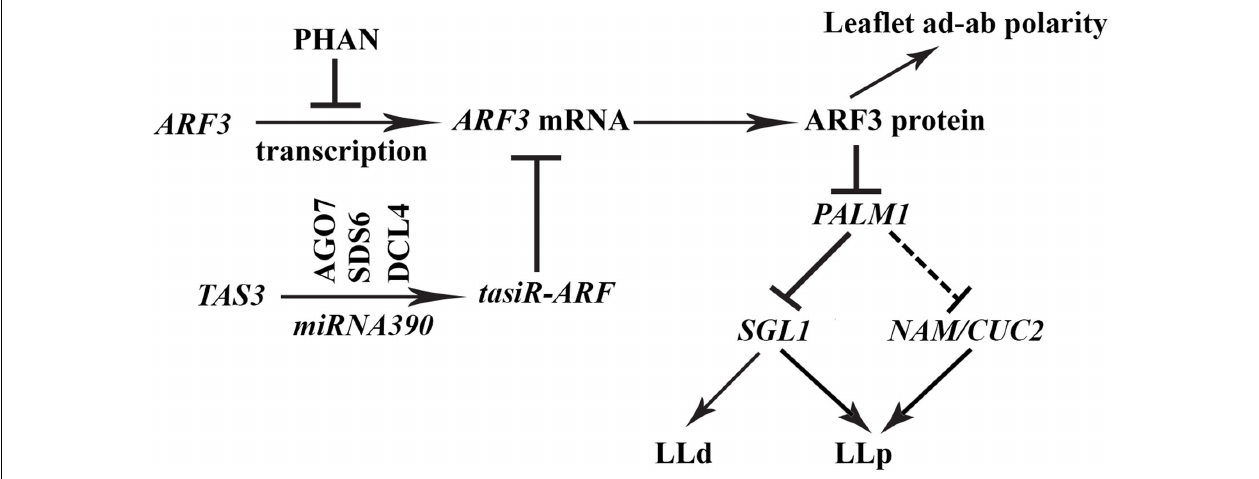
FIGURE 9 | A genetic model illustrating the role of the ARF3-PALM1 module in dissected leaf development in M. truncatula . The MYB domain protein PHAN negatively regulates transcription of ARF3 and the trans -acting short interfering RNA, tasiR -ARF, whose biogenesis is dependent on the AGO7-SDS6-DCL4-miRNA390 pathway, negatively regulates the transcript level of ARF3 . ARF3 in turn negatively regulate the expression of PALM1 , a negative regulator of the Medicago LEAFY ortholog, SGL1 , which is required for the initiation of lateral leaflets in M. truncatula . A fine-tuned expression of PALM1 and SGL1 is crucial for the development of trifoliate leaves in M. truncatula . NAM/CUC2 , whose expression is repressed directly or indirectly by PALM1 , is required for the initiation of proximal lateral leaflets (LLp) in the palm1 mutant. Solid and dashed lines denote confirmed and unconfirmed molecular interactions, respectively. LLd, distal lateral